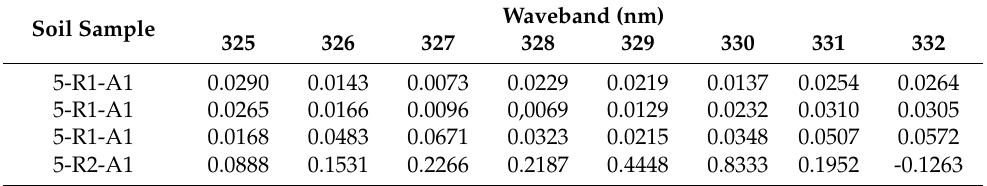
Table 2. Sample of the reflectance measured by the handheld spectrometer (abbreviated).